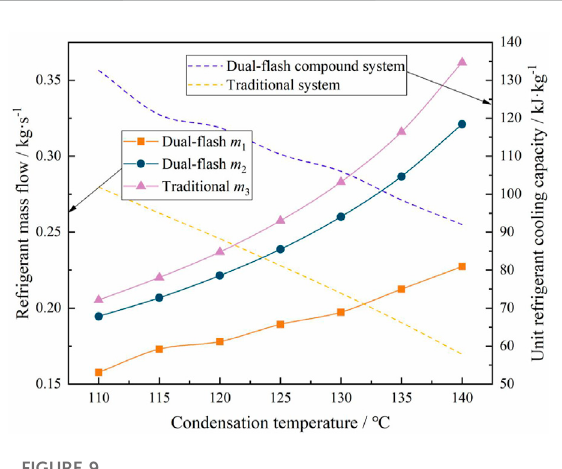
FIGURE 9 Refrigerant changes with condensing temperature under rated cooling